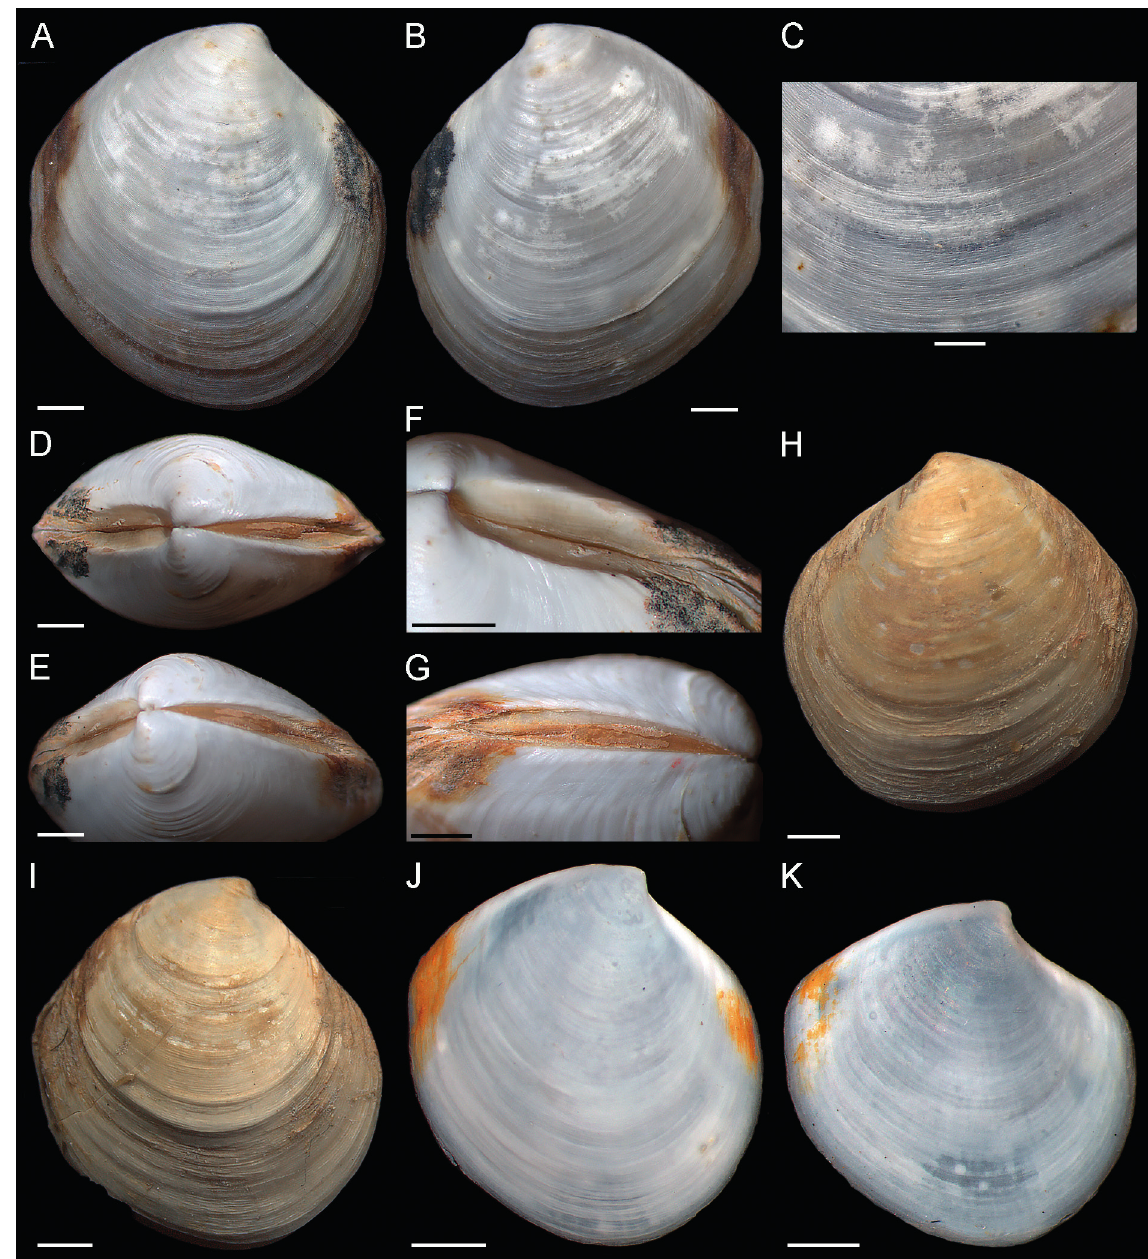
Fig. 8. Parathyasira pauli sp. nov. A–G . Holotype (IORAS OBF collection Cat. BIV00039), exterior and dorsal views of both valves, shell length 7.6 mm. H . Paratype (MIMB 43823), shell length 7.0 mm. I . Paratype (IORAS OBF collection Cat. BIV00040), shell length 6.5 mm. J–K . Variability of shell shape (IORAS OBF collection Cat. BIV00041). J . Shell length 4.9 mm. K . Shell length 3.8 mm. Scale bars: A–B, D–K = 1 mm; C = 500